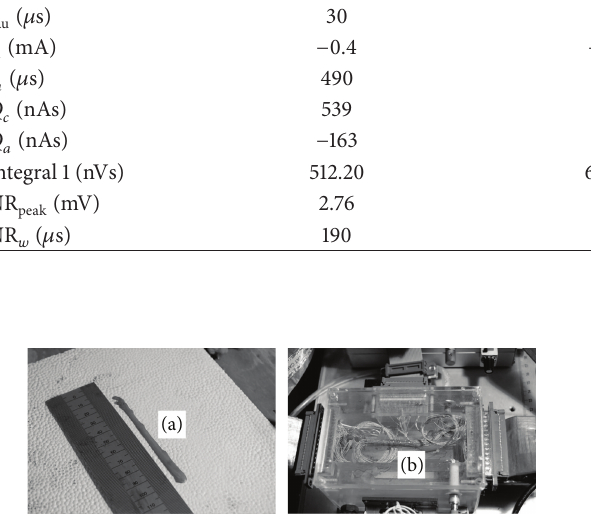
Figure 3: (a) Isolated LVN and (b) LVN within the cuff mounted into an experimental